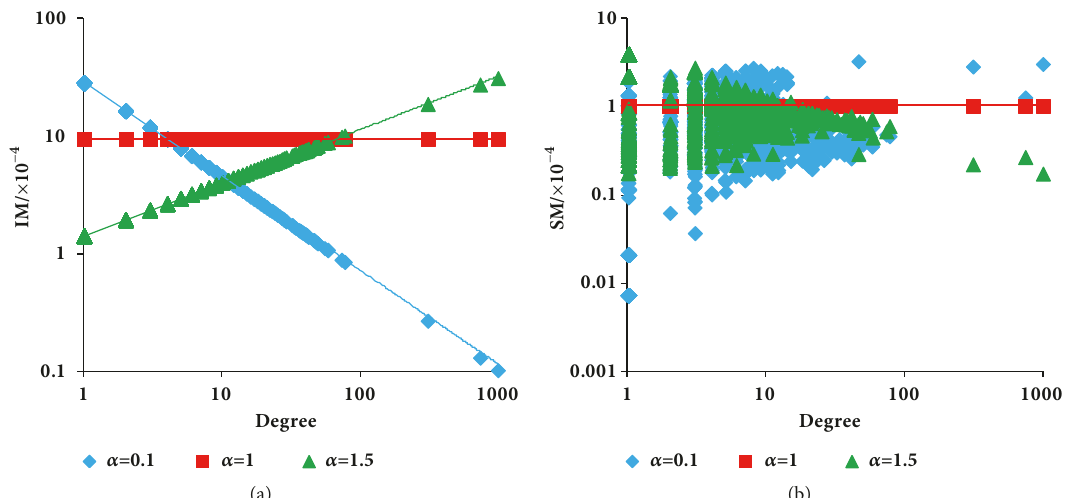
Figure 6: The relationship between metrics and degree in NDR. (a)IM and (b)SM.